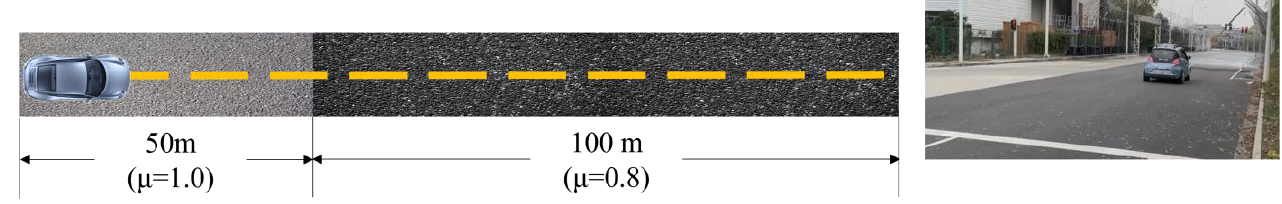
Figure 18. Vehicle test condition.